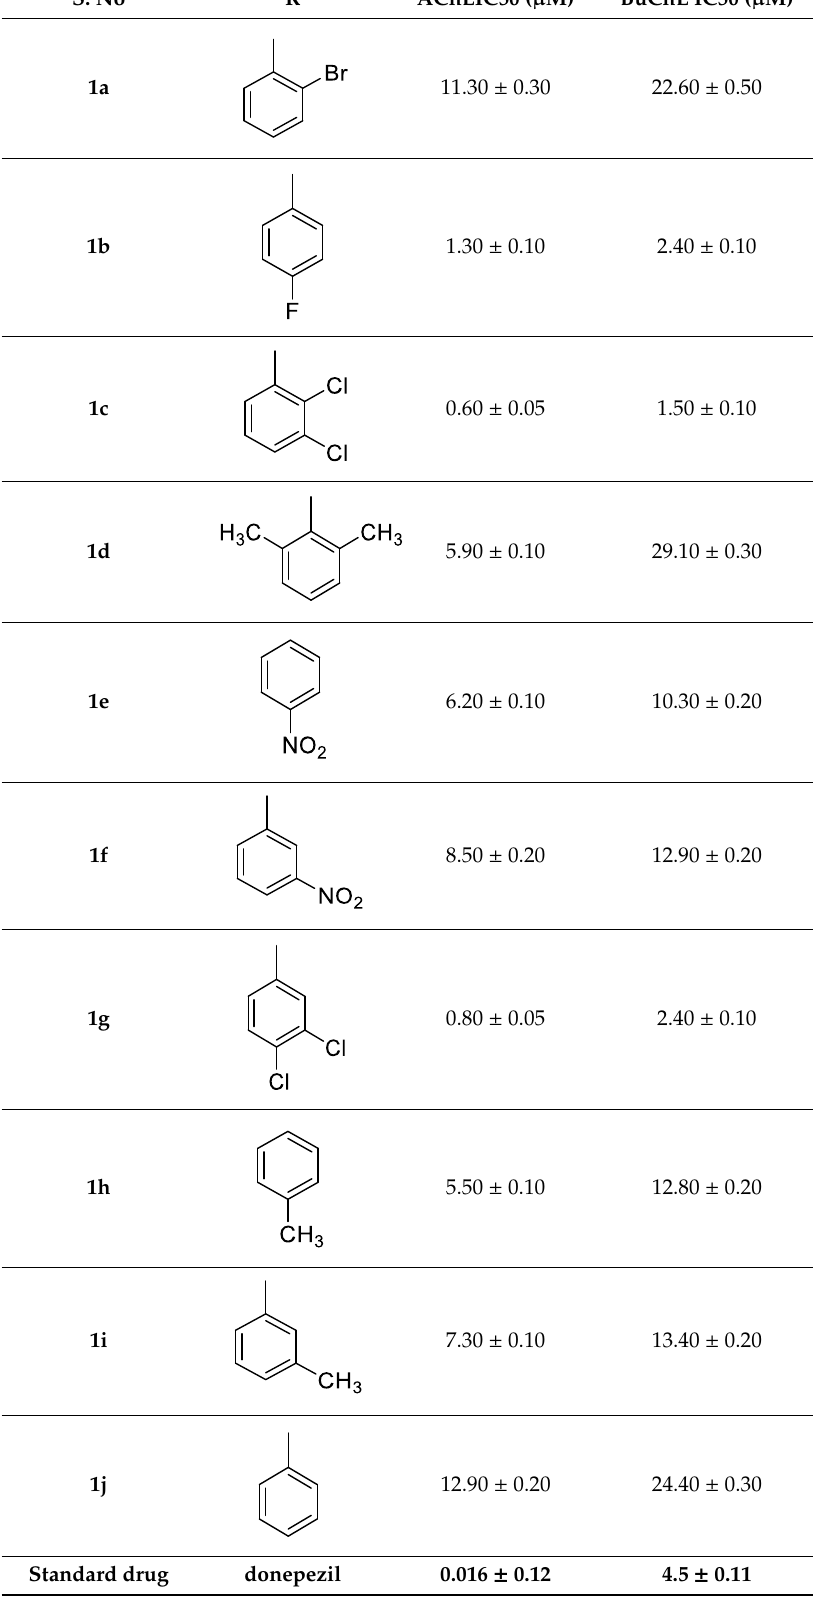
Table 1. Structure and acetylcholinesterase inhibition activities of benzimidazole thiosemicarbazide analogs.